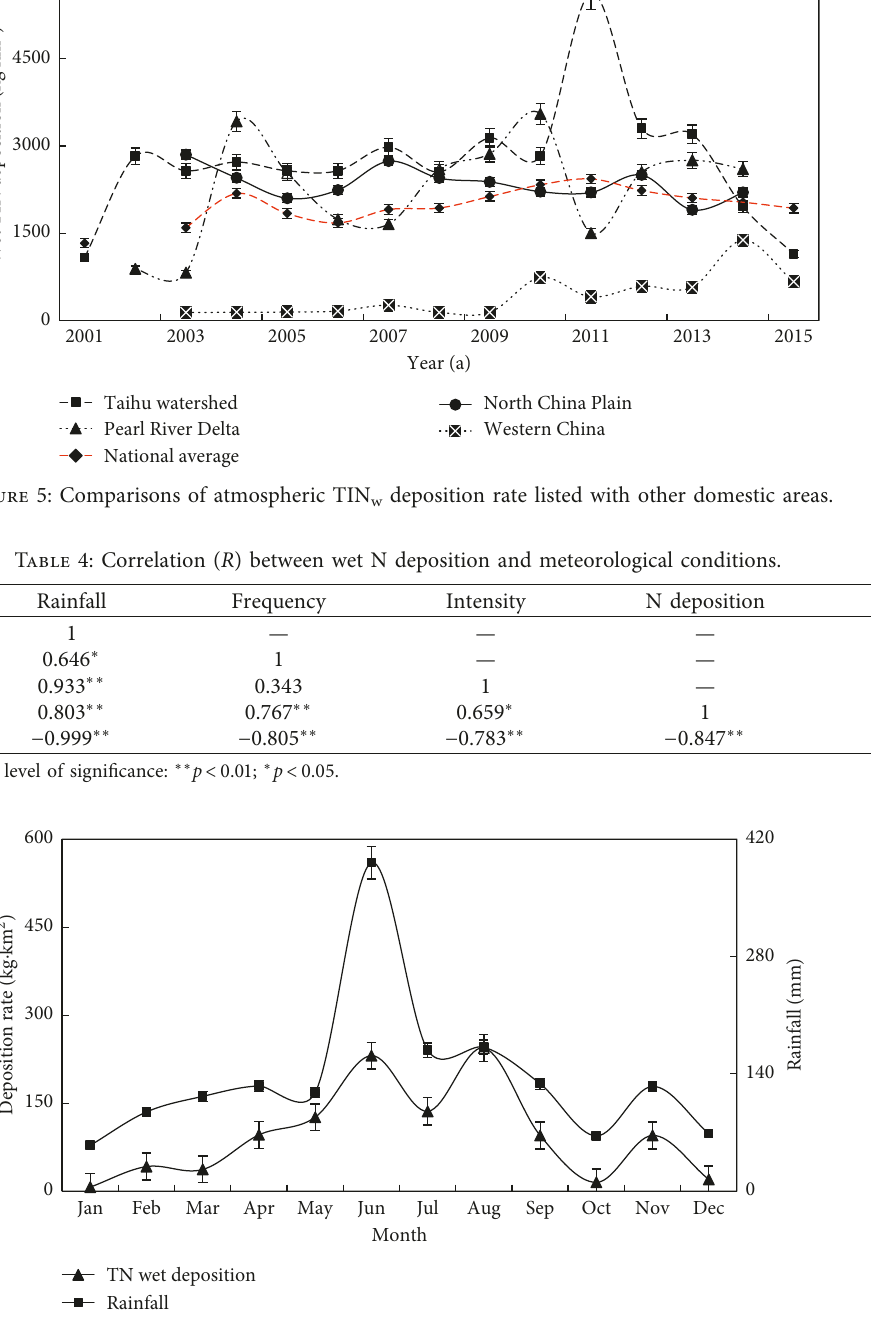
Figure 6: Monthly rainfall and TN